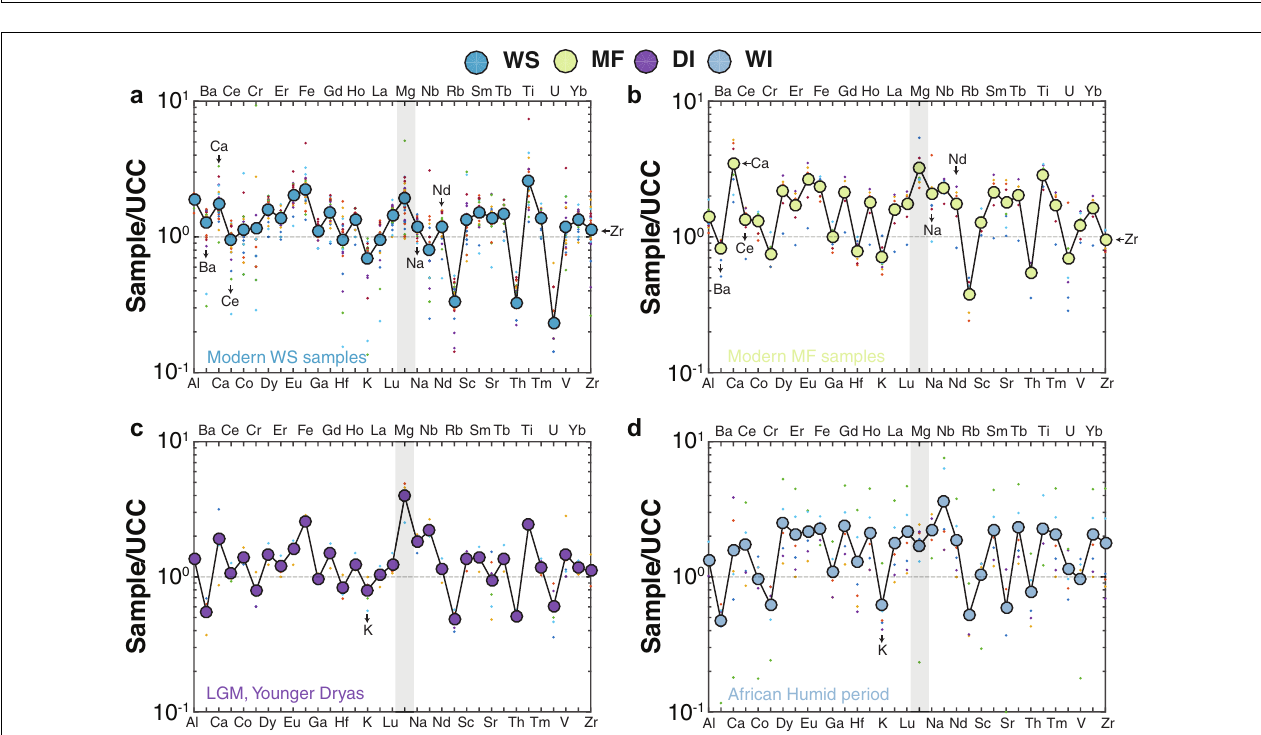
FIGURE 6 | Ternary plots of (a) A-CN-K, and (b) A-CNK-FM illustrating the degree of alteration in WS, MF, WI, and DI samples. WS, modern watershed sample; and MF, modern mudflat sample.